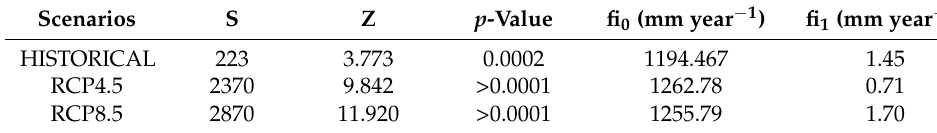
Table 2. The results of the Mann–Kendall test and Theil–Sen regression.